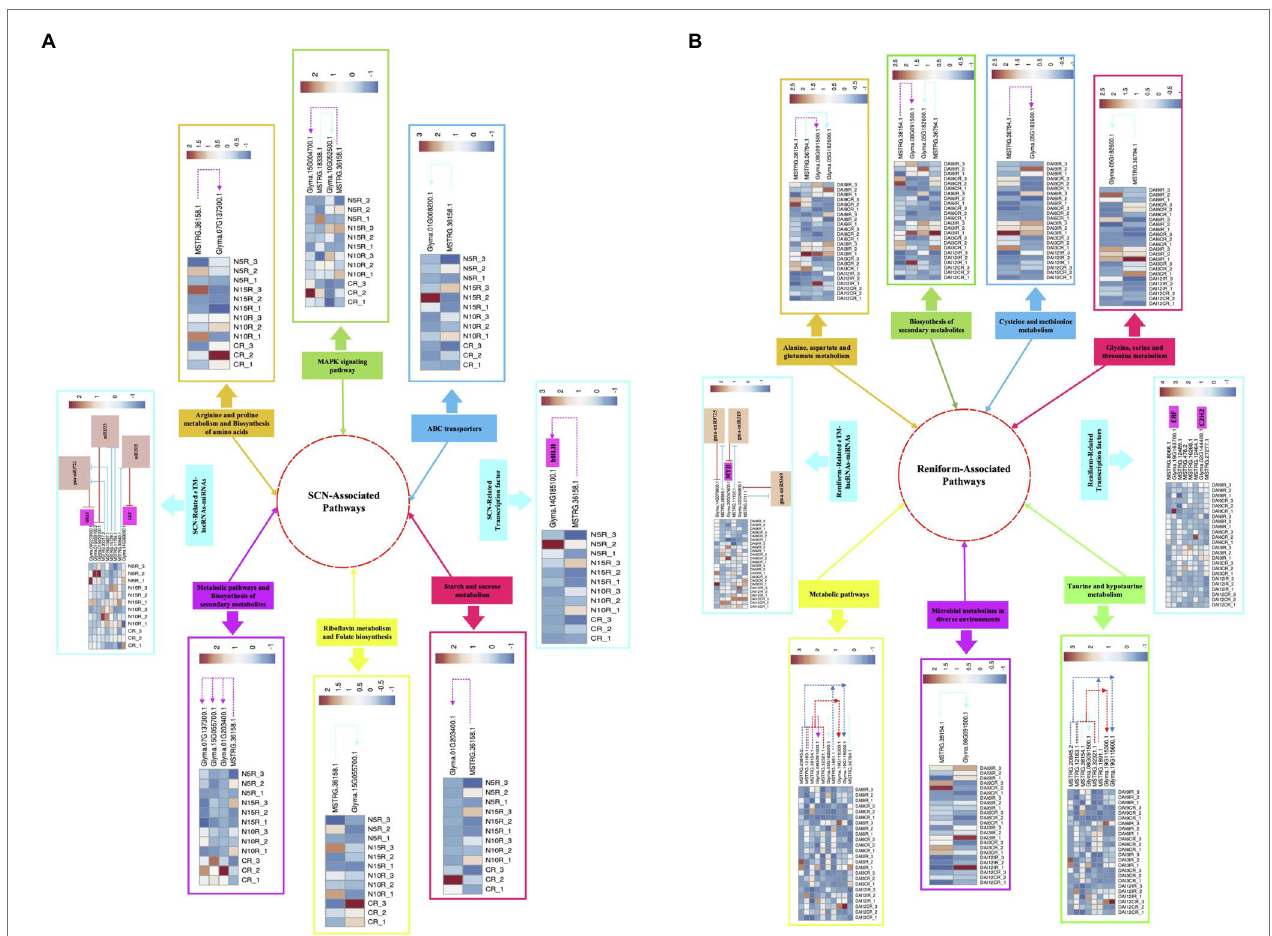
FIGURE 10 | The schematic representation of probable regulatory mechanism in response to PPNs infection in soybean. The proposed model illustrating the SCN- associated pathways (A) and reniform-associated pathways (B) in which lncRNAs regulate their nematode-responsive target gene expression (including protein- coding genes and TFs). Additionally, in this model, the involvement of lncRNAs in miRNA-mediated regulation of gene expression under nematode infection has been displayed. The heatmaps represent the expression patterns of lncRNAs and their potential target genes in each